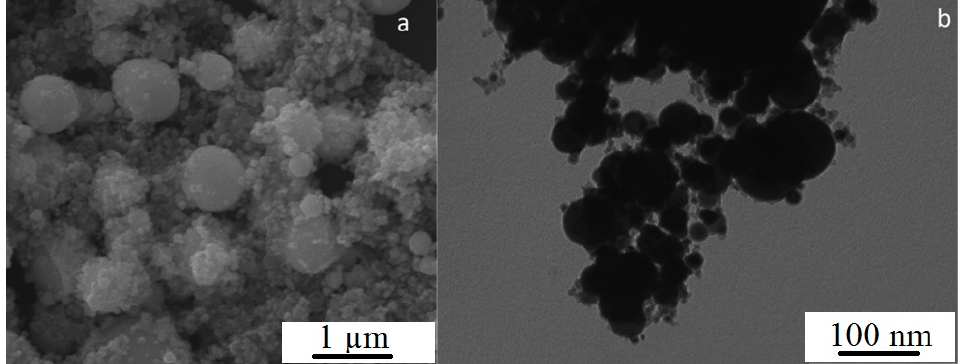
Figure 1. Images of W nanoparticles: ( a ) SEM; ( b ) TEM. W powder particles have a regular spherical shape (Figure 1), formed during the electrical explosion of the conductor. The average size of a W particle is 200 nm (Figure 1b). In the W powder, large metallic particles are observed, the size of which reaches 10 µm.